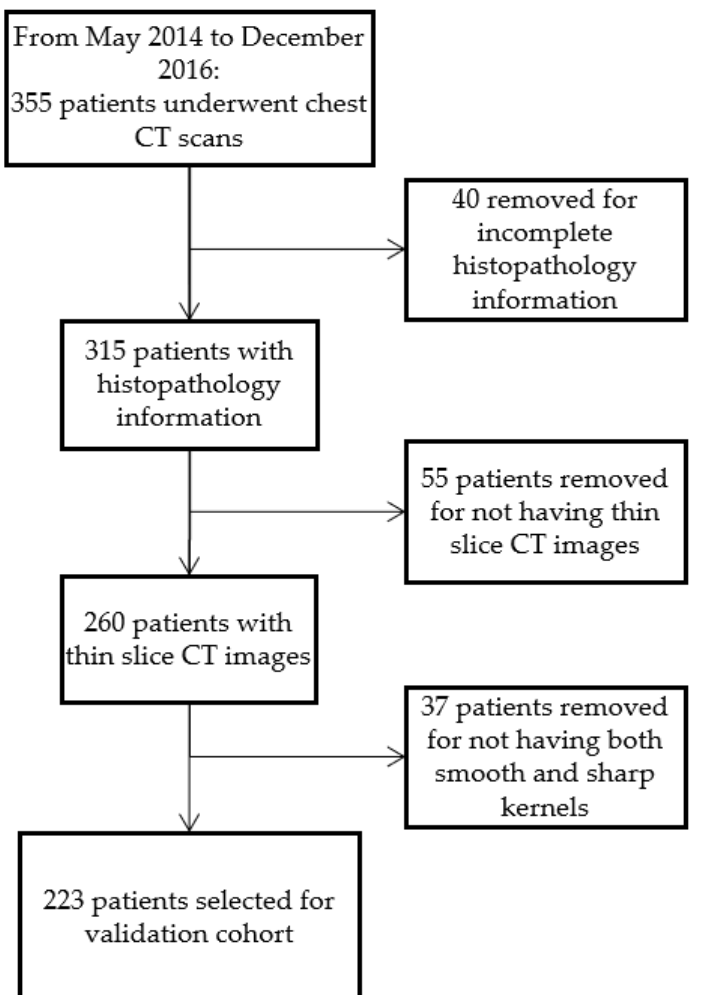
Figure 2. Flow chart of validation cohort patient selection process.